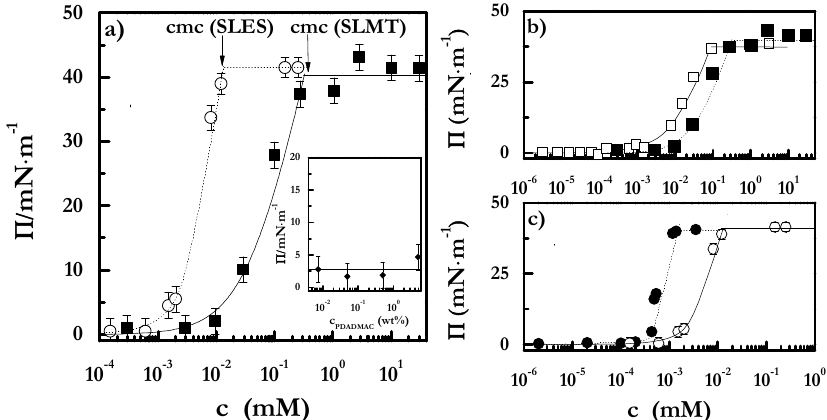
Figure 2. Results obtained using a drop profile analysis tensiometer: ( a ) Surface pressure dependence on surfactant concentration for the adsorption of pure SLES ( ○ ) and SLMT ( ■ ) at the water–vapor interface; cmc for both surfactants is marked. The inserted panel represents the surface pressure dependence on PDADMAC concentration for the adsorption of pure PDADMAC at the water–vapor interface. ( b ) Surface pressure dependence of SLMT concentration for pure SLMT ( ■ ) and PDADMAC–SLMT ( □ ) solutions. ( c ) Surface pressure dependence of SLES concentration for pure SLES ( ○ ) and PDADMAC–SLES ( ● ) solutions. The lines are guides for the eyes. The results for PDADMAC-surfactant mixtures correspond to mixtures containing a fixed PDADMAC concentration of 0.5 wt.%, and left to age for one week prior to measurement.